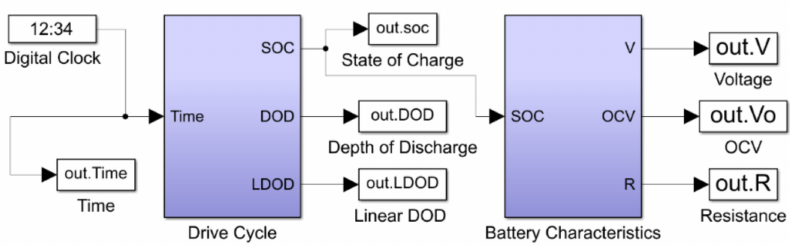
Figure 2. Top-level of the electric vehicle cycle and characteristics